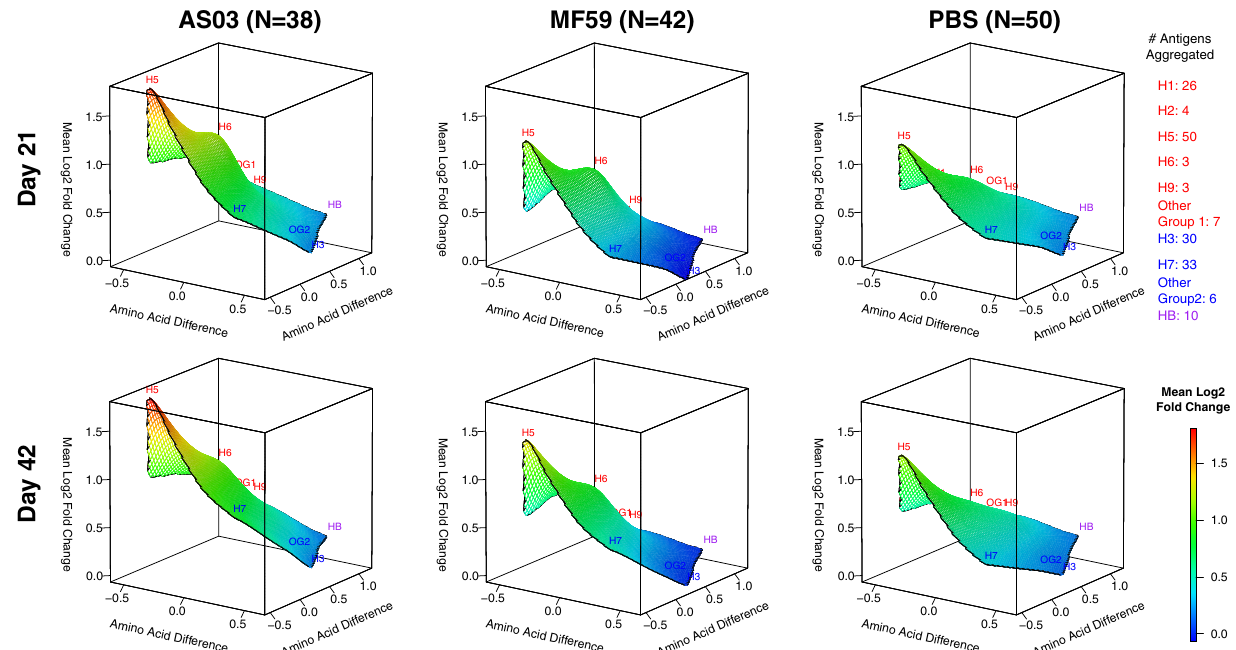
Fig. 7 All three vaccines elicited increased IgG antibodies against full-length H5 proteins after the fi rst dose without further boosting after the second dose. IgG antibody landscapes for HA0 antigens based on mean log 2 fold change relative to pre-vaccination adjusted for seasonal in fl uenza vaccination (Experiment 2). In red: Group 1 HA0 antigens, in blue: Group 2 HA0 antigens, in purple: in fl uenza B HA0. The y and x axes project antigen protein sequence divergence as measured in the number of amino acid differences between antigen proteins using multidimensional scaling. For each antigen, fi rst the mean log 2 fold change in antibody fl uorescent intensity relative to pre-vaccination adjusted for prior seasonal in fl uenza vaccination was determined (LSMEAN). For subtypes with multiple antigens, the mean LSMEAN and MDS dimensions were used to present the results in the 3D space.